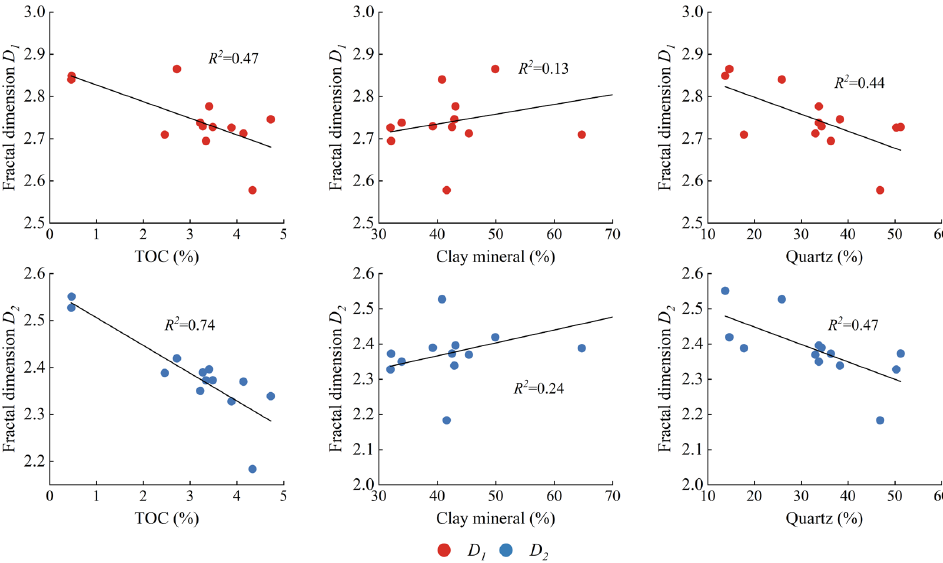
Figure 12. Relationship between fractal dimension and TOC and mineral